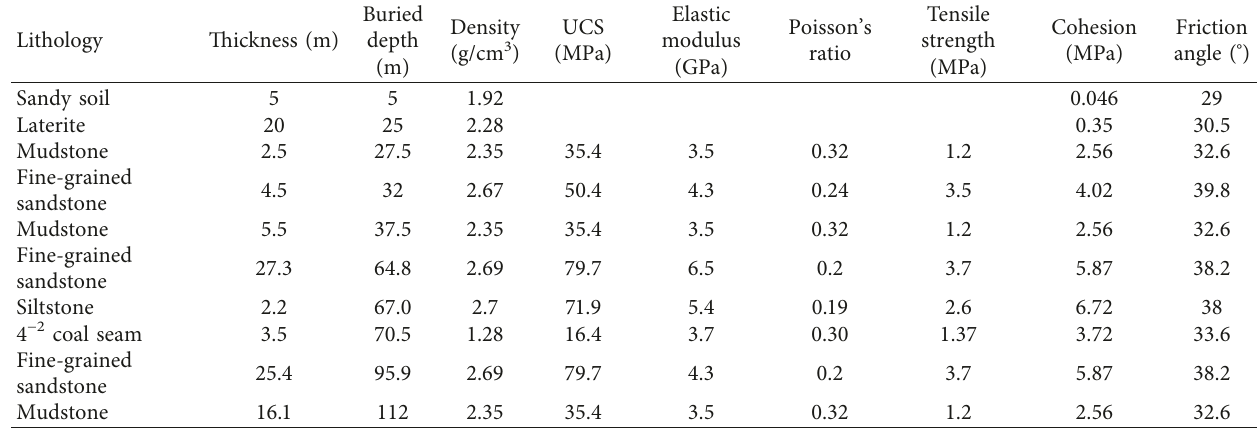
Table 2: Physical and mechanical parameters of the 4 − 2 coal seam overlying